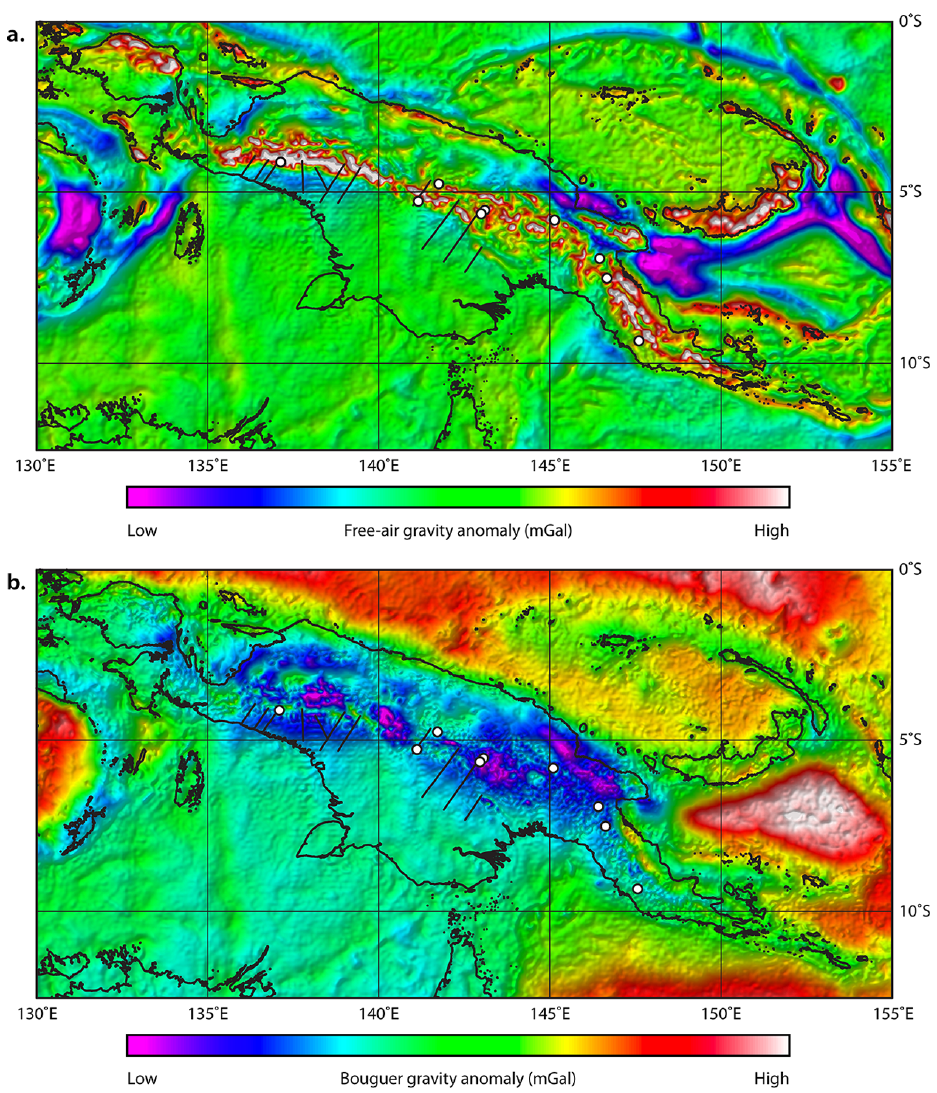
Fig. 6. (a) Free-air and (b) Bouguer gravity data sets obtained from the Bureau Gravimetrique Internationale (BGI) show that there are several major N–S- and NE–SW-trending structures cutting across the Arafura Sea. These data also indicate that the majority of structures in southern New Guinea trend N–S. However, there are some NNE–SSW-trending structures in central and northern New Guinea. This indicates that if any NNE–SSW striking faults occur in New Guinea, they are perhaps unrelated to the inherited fabric of the Australian lithosphere. The light source in these images is from the southeast to highlight NE-trending structures. The same images were generated with different illumination angles to interpret lineaments with other orientations. The location of major Au/Cu/Ag/Mo deposits is shown as white circles (See Fig. 1a for more details). The NNE-trending lineaments that were proposed by Hill (1991) and Kendrick et al. (1995) are shown as thin black